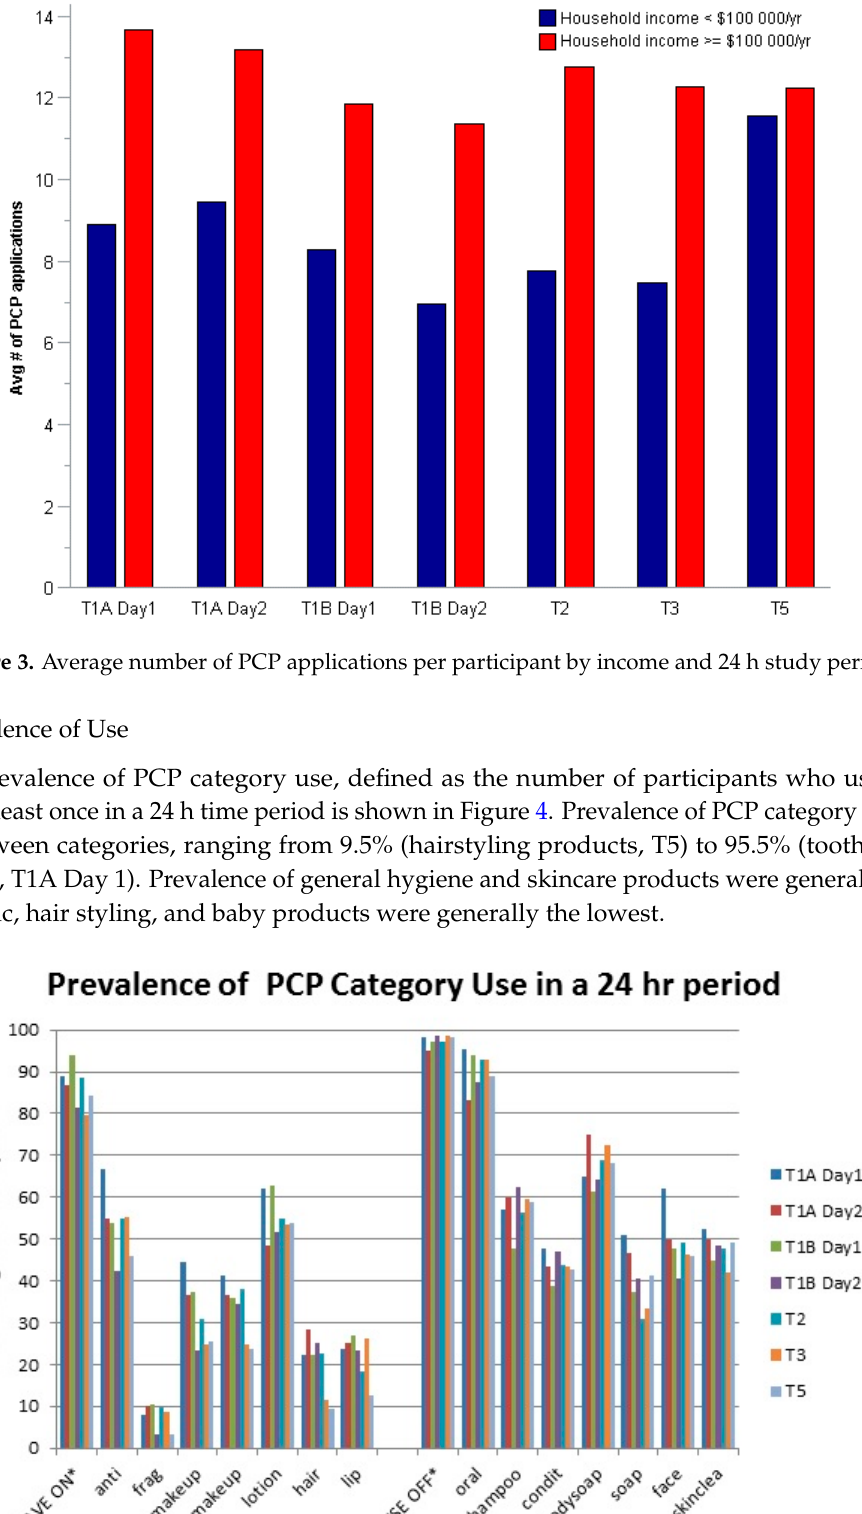
Figure 2. The total number of PCP applications within a 24 h period and household income group. The diamond inside the box indicates the mean value and the line inside the box indicates the median value. The bottom and top edges of the box indicate the 25th and 75th percentiles. The vertical lines represent the range of values with outliers indicated by circles.